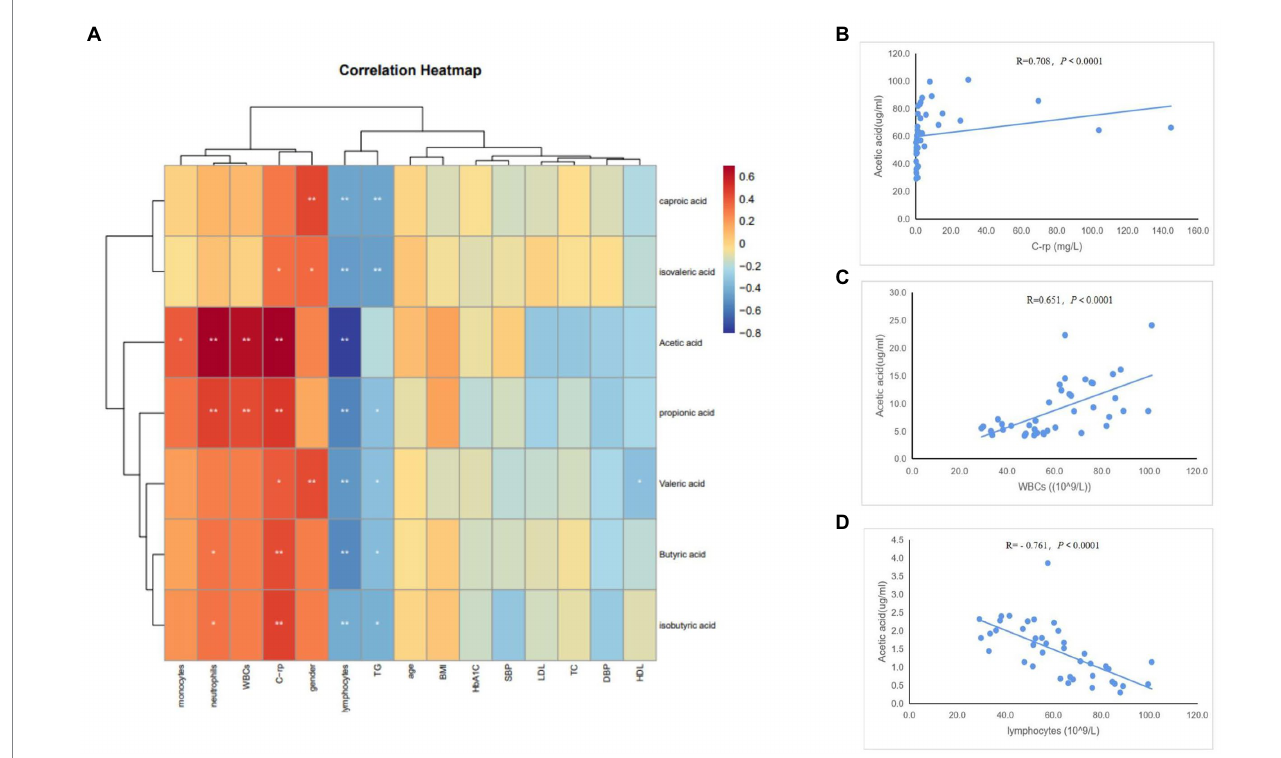
FIGURE 6 Spearman correlation analysis of different SCFAs and clinical characteristics. (A) Heatmap showing the correlation between different SCFAs and clinical characteristics. (B) Scatter plots showing the correlation between acetic acid and C-rp. (C) Scatter plots showing the correlation between acetic acid and WBCs. (D) Scatter plots showing the correlation between acetic acid and lymphocytes. The color intensity represents magnitude of correlation. Red reflects positive correlations, blue reflects negative correlations; * p < 0.05; ** p <